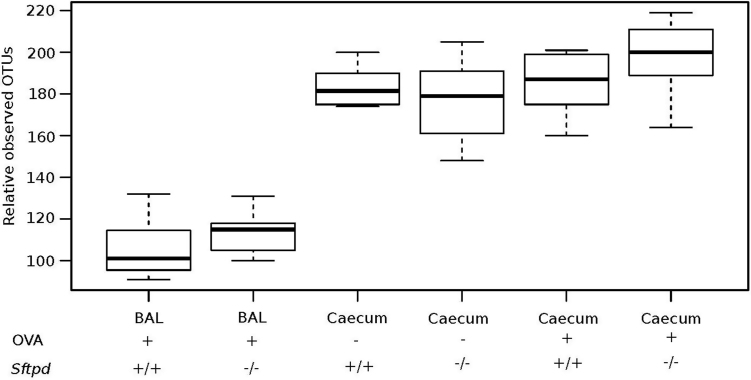
Bacterial richness. Relative observed OTUs in BAL and caecum from different experimental groups. The number of OTUs relative to each other from the different experimental groups at even sequencing depth with added variation bars. There is a significantly more OTUs in caecum samples regardless of mouse genotype and treatment compared to OTUs from BAL samples from OVA treated mice (Wilcoxon test, p < 0.001).